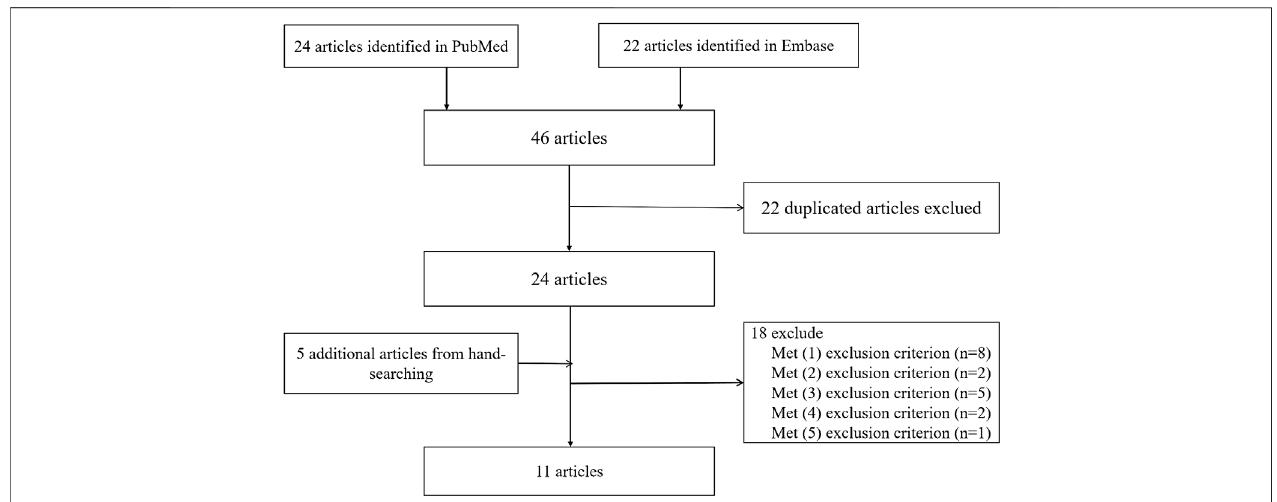
FIGURE 1 | Flow chart of study selection in this